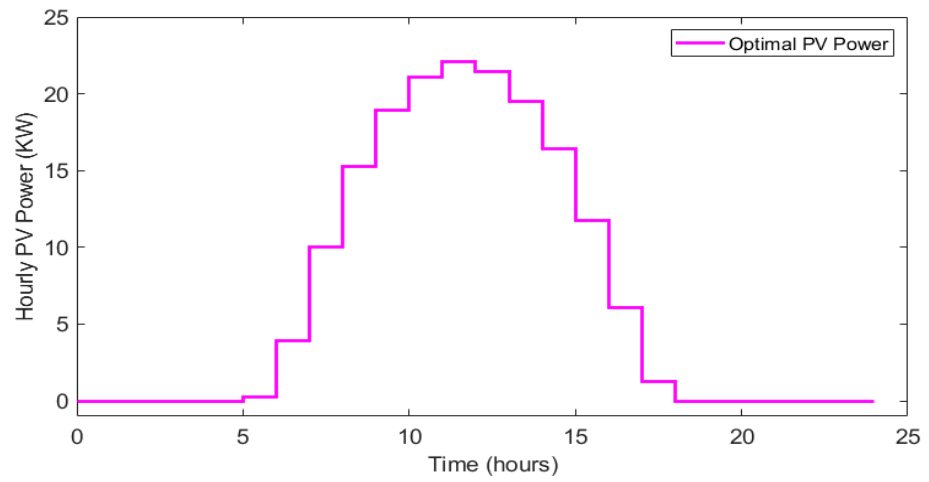
Figure 11. Optimal PV Generated Power.